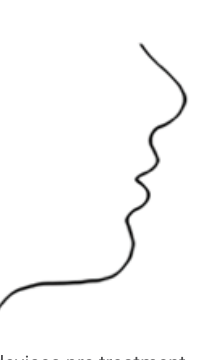
Figure 1. Silhouette of advancement devices pre treatment.